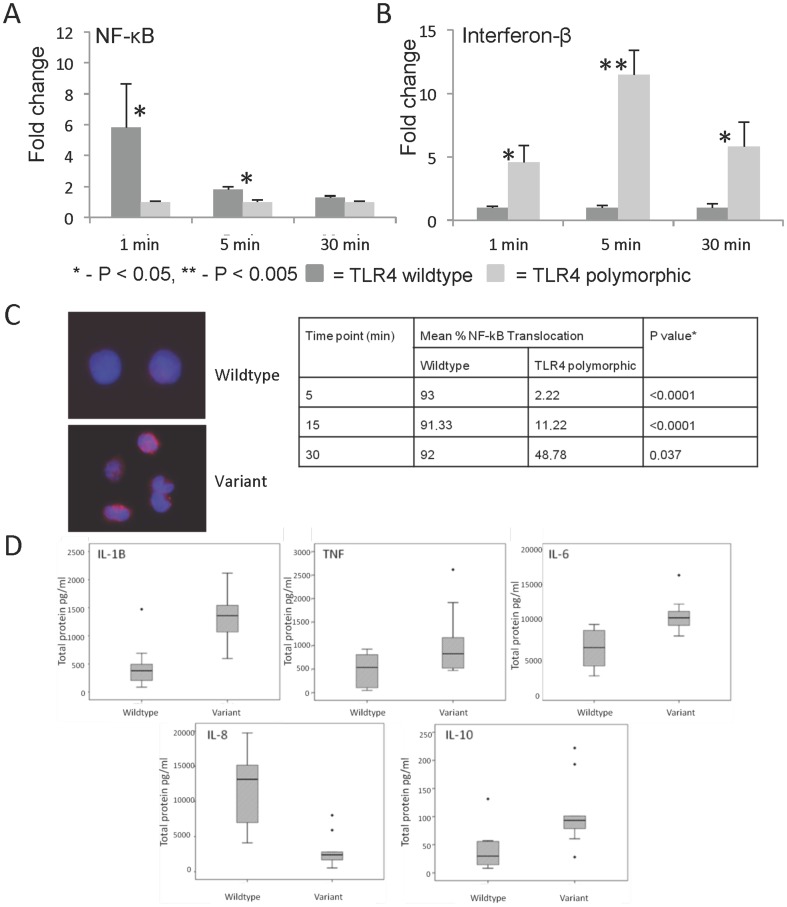
TLR4 Asp299Gly and Thr399Ile polymorphisms have dysregulated LPS-induced TLR4 signalling.(A and B) TLR4 polymorphisms affect gene expression in both the MyD88 dependent and independent signalling pathways. NF-κB and IFN-B gene expression following E. coli LPS stimulation (1 µg/ml) depicted as fold change after normalisation to unstimulated values. Graphical representation reflects fold change difference between median values from wildtype and TLR4 polymorphic carriers. Error bars  =  Standard error. (C) TLR4 polymorphisms inhibit p65-phosphorylation Human PBMCs were incubated with or without E. coli LPS (1 µg/ml) upto 30 mins (15 min LPS stimulation depicted) and then analysed for the distribution of p65 by immunofluorescence. Red stain indicates the localization of p65, and blue stain indicates the nucleus (magnification, 200x). Mean percentage of NF-κB translocation in peripheral blood derived monocytes from wildtype individuals and carriers of the TLR4 Asp299Gly polymorphism. Data generated from 3 individuals per group tested in 3 separate experiments. *T-test statistic for comparison at each time point between wildtype and TLR4 variant carriers. (D) TLR4 polymorphisms affect downstream cytokine production. Box-and-whisker plots of cytokine production by monocytes from wildtype and TLR4 Asp299Gly and Thr399Ile polymorphic carriers stimulated with E. coli LPS (1 µg/ml) for 24 h. The bold lines represent medians, and the span of the box represents the interquartile range of the data, * depicts outliers. Data is generated from sample groups of 10 volunteers.